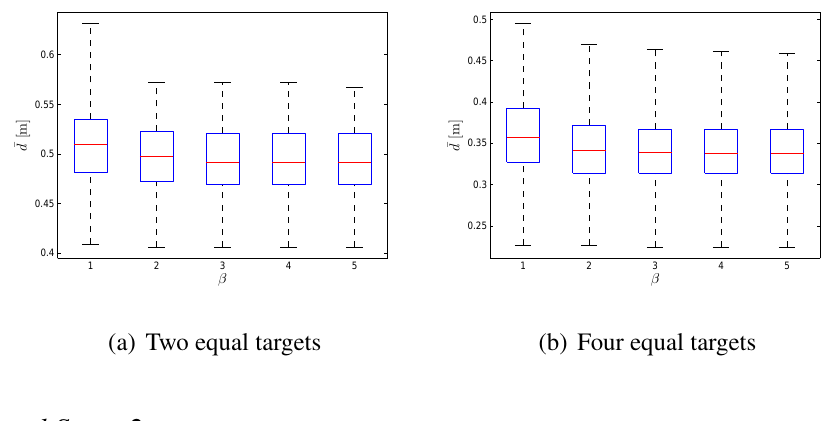
Figure 2. Box-plot comparison shows the average distance crossed by a robot: (a) 40 robots, 2 equal targets, (cid:11) = 1 ; (b) 40 robots, 4 equal targets, (cid:11) = 1 . Each box-plot comprises observations ranging from the first to the third quartile. The median is indicated by a horizontal bar, dividing the box into the upper and lower part. The whiskers extend to the farthest data points that are within 1.5 times the interquartile range. Outliers are shown with a plus symbol. The values were obtained from 50